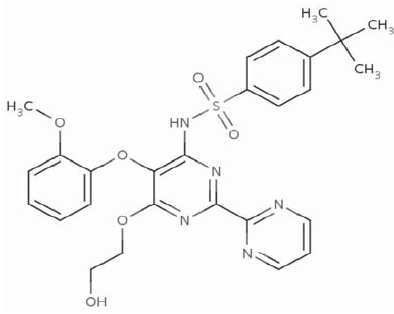
Figure 1. Chemical structure of Bosentan